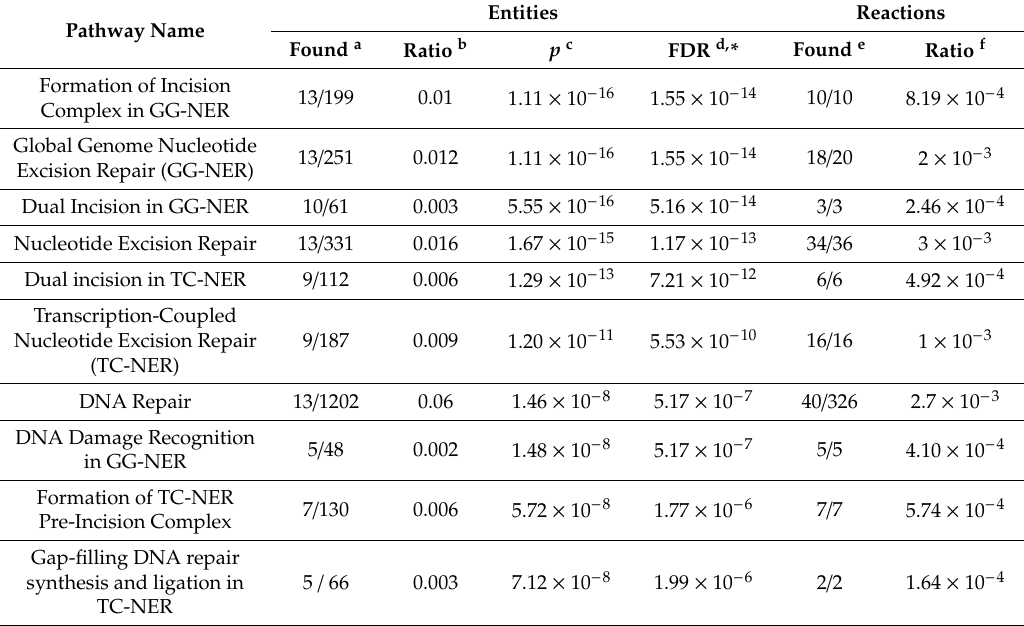
Table 6. Pathway enrichment analysis for genes of the age at first calving network. The following table shows the 10 most relevant pathways sorted by p -value.